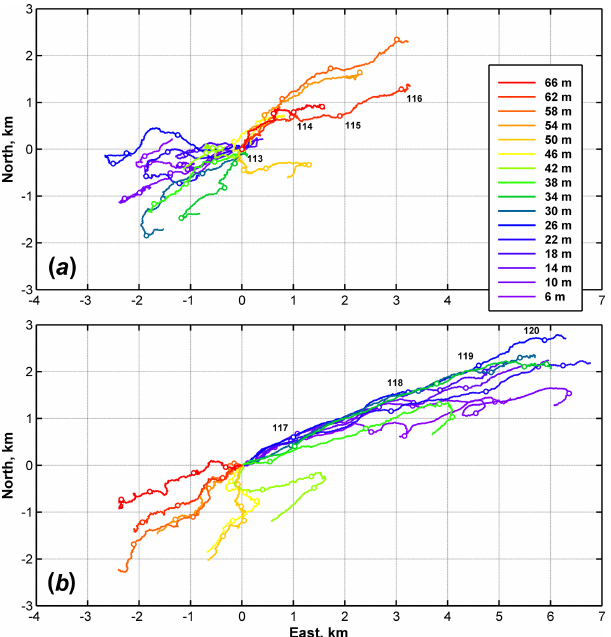
Figure 5. The progressive vector diagram showing the residual (de- tided) currents during events (a) A (DOY 113.0–116.5) and (b) B (DOY 116.5–120.5). Circles indicate every DOY day at